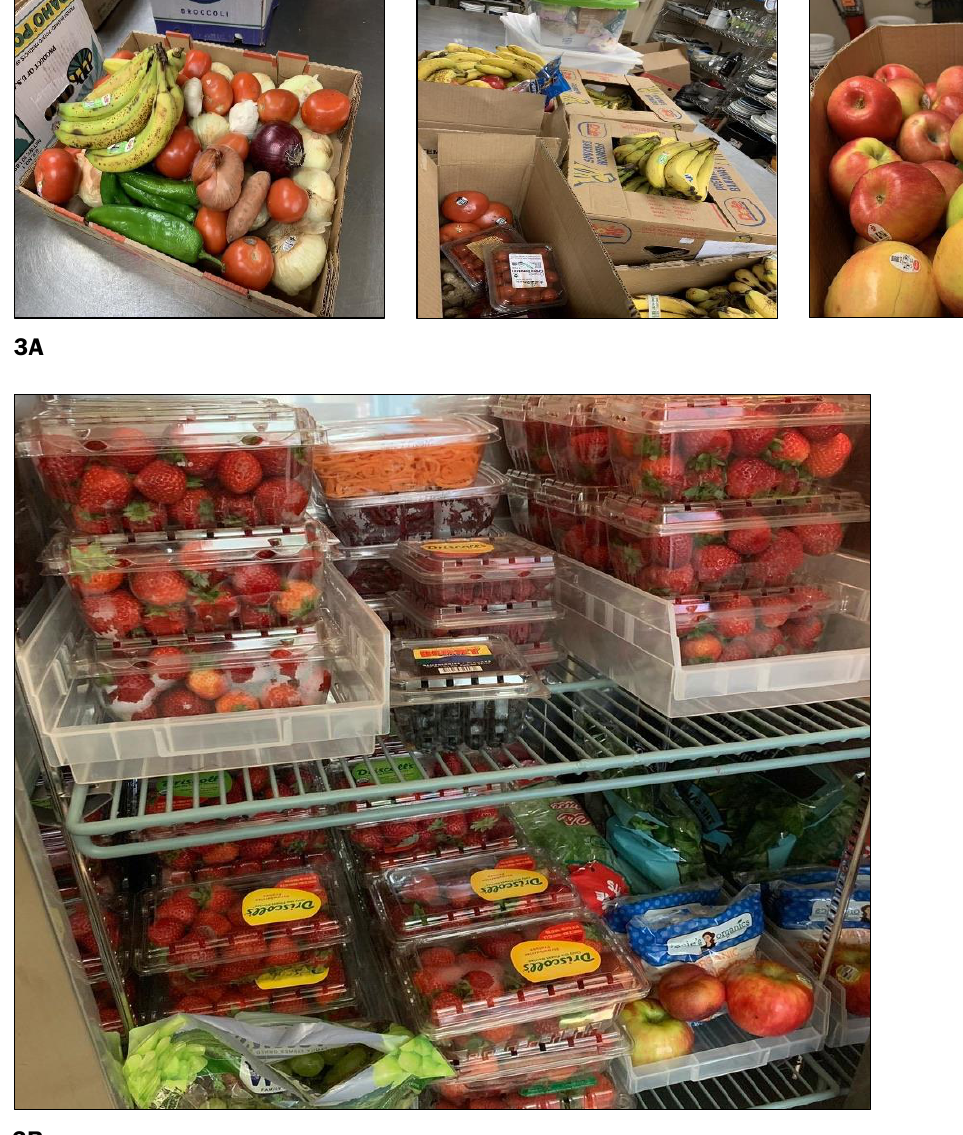
Figure 3A and B. (A) Raw Produce is Brought to a Central Location. (B) Produce is Methodically Sorted and Organized Photo courtesy Campus Food